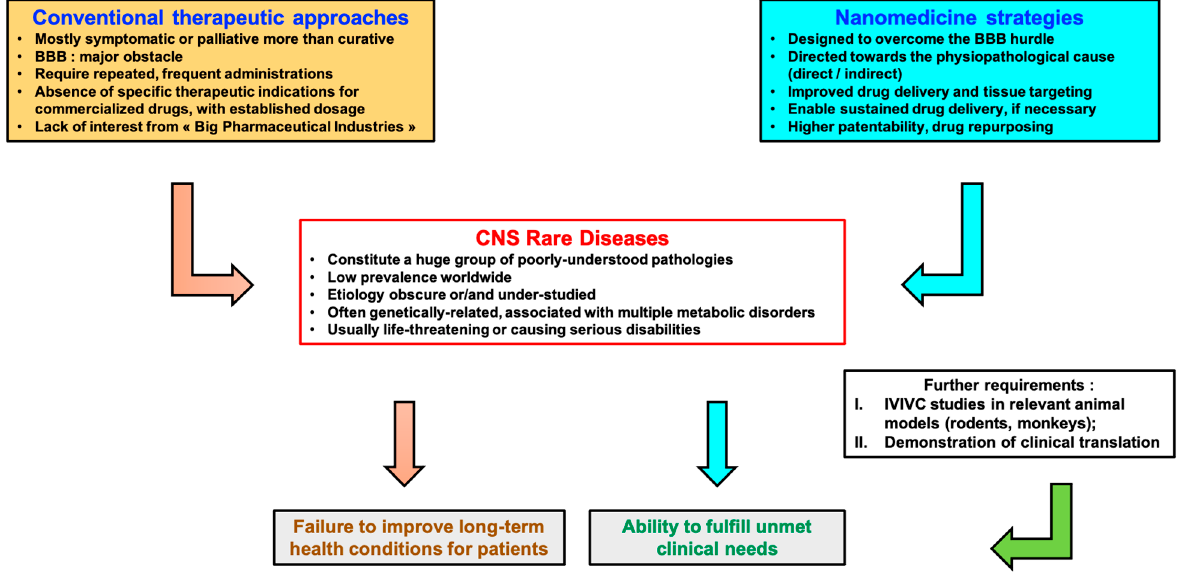
Figure 1. Comparative scheme representing the curative benefits of nanomedicine strategies vs. conventional therapeutics.